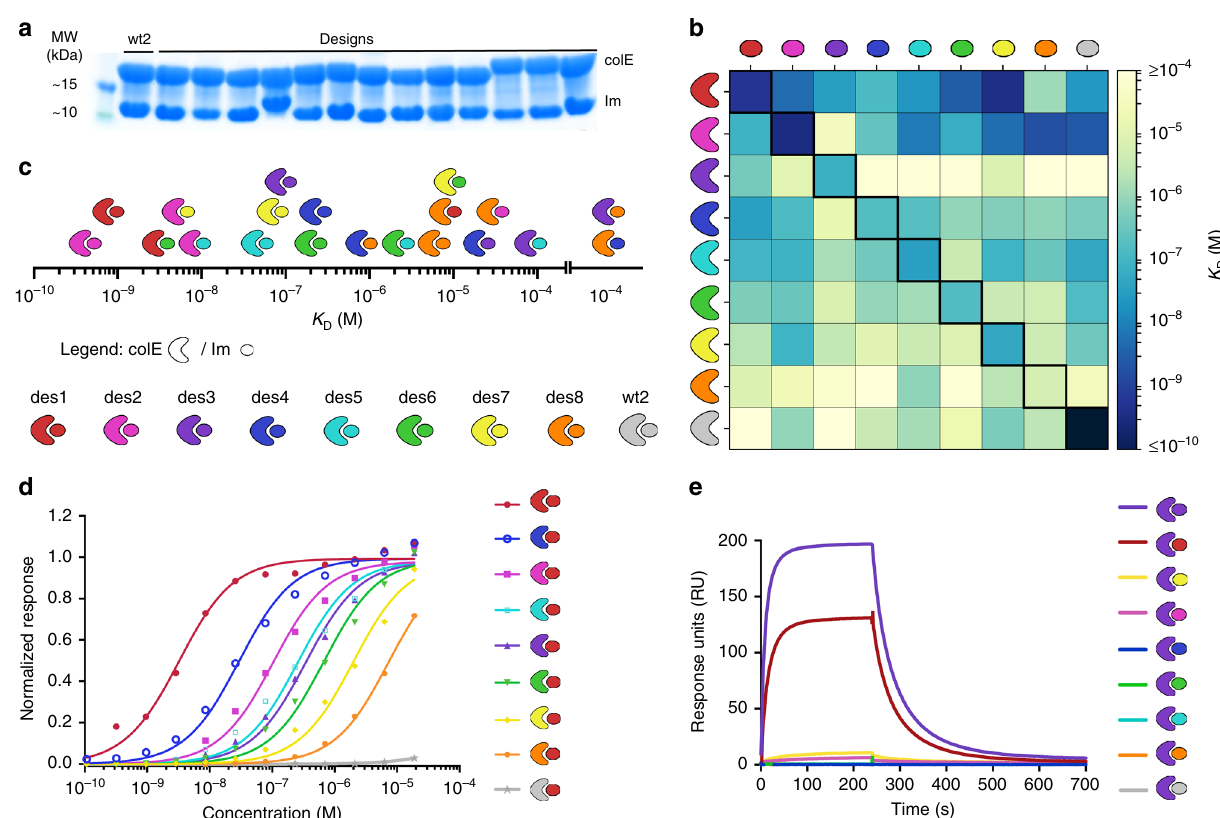
Fig. 3 Af fi nity and speci fi city in the designed interaction network. a Co-expression and af fi nity-puri fi cation of 13 representative colE/Im designs and colE wt2 /Im wt2 indicate that the design pairs express well and interact. b Interaction af fi nities of eight selected designs to their cognate (diagonal) and non- cognate (off-diagonal) partners and to wt2, determined by surface plasmon resonance (SPR). Design color-coding shown to the left of the panel. The colE wt2 /Im wt2 interaction was also measured (Supplementary Fig. 3), but the af fi nity value reported here ( K D = 4 × 10 − 15 M) was taken from previous stopped- fl ow measurements, which provide better resolution at ultrahigh af fi nities 9 . Numerical K D values and fi tting methods are available in Supplementary Table 1. Kinetic constants and fi tted sensograms for the six cognate interactions that were determined kinetically and for colE wt2 /Im wt2 are shown in Supplementary Figure 3. c Interaction af fi nities span seven orders of magnitude, from high picomolar to high micromolar. d Im des1 shows 59 to 170,000-fold pairwise speci fi city for its cognate colE des1 (red curve) over non-cognate counterparts. Binding of Im des1 to cognate and non-cognate colE proteins was measured using SPR at different Im concentrations and normalized to the maximal response at saturating concentrations ( R max ) extracted by af fi nity fi tting. e colE des3 shows 6- to 1400-fold speci fi city for its cognate Im des3 (purple sensogram) over non-cognate partners. SPR binding sensograms are presented at 233 nM Im